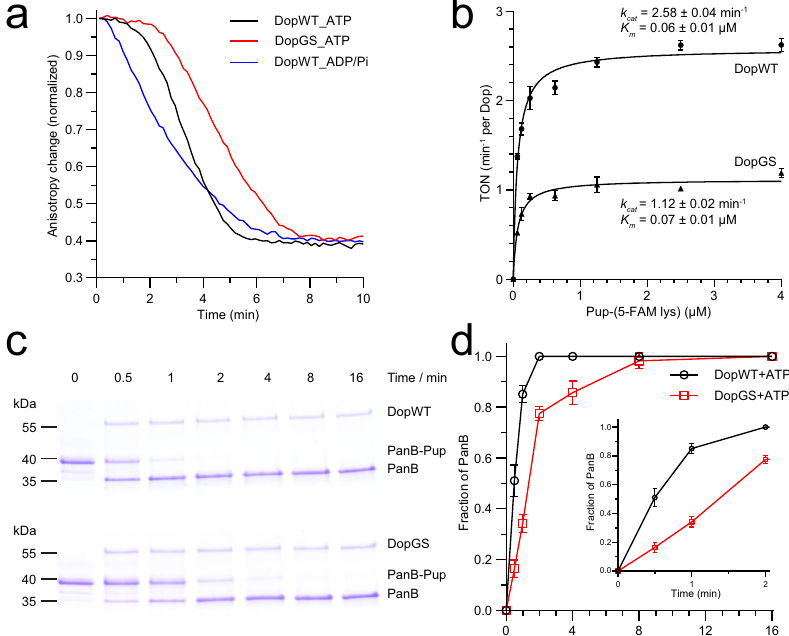
Fig. 3 ATP hydrolysis of Dop is allosterically in fl uenced by the Dop-loop. a The Dop-loop variant (DopGS) exhibits a longer phase in the depupylation time course of the fl uorescent model substrate Pup-(5-FAM-Lys) (Pup-Fl) than the wild type (WT) enzyme in the presence of ATP. 1.25 µ M Cglu Dop (WT or DopGS variant) was incubated with 5 μ M Pup-Fl and 100 µ M ATP or ADP plus 10 mM Na/K Pi (pH 8.0 at 23 °C) at 30 °C. The measurement was started by addition of nucleotide. Each line represents the average of three independent replicates. b Steady-state enzyme kinetic analysis of depupylation of Pup-Fl by using fl uorescence anisotropy. Each experiment was carried out in three independent replicates and data are represented as mean values ± SD. c Depupylation time courses of PanB-Pup catalyzed by Dop variants in the presence of ATP. PanB-Pup (3 µ M) was incubated with 0.5 µ M Cglu Dop (DopWT or DopGS) at 30 °C supplemented with 0.5 mM ATP. d Densitometric analysis of PanB bands in ( c ) with respect to the total amount of PanB-Pup used in the reaction. Each reaction was carried out in two or three independent replicates and data are represented as mean values ±